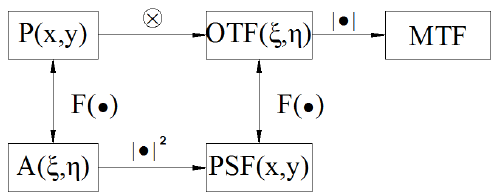
Figure 2. The calculation flow chart.